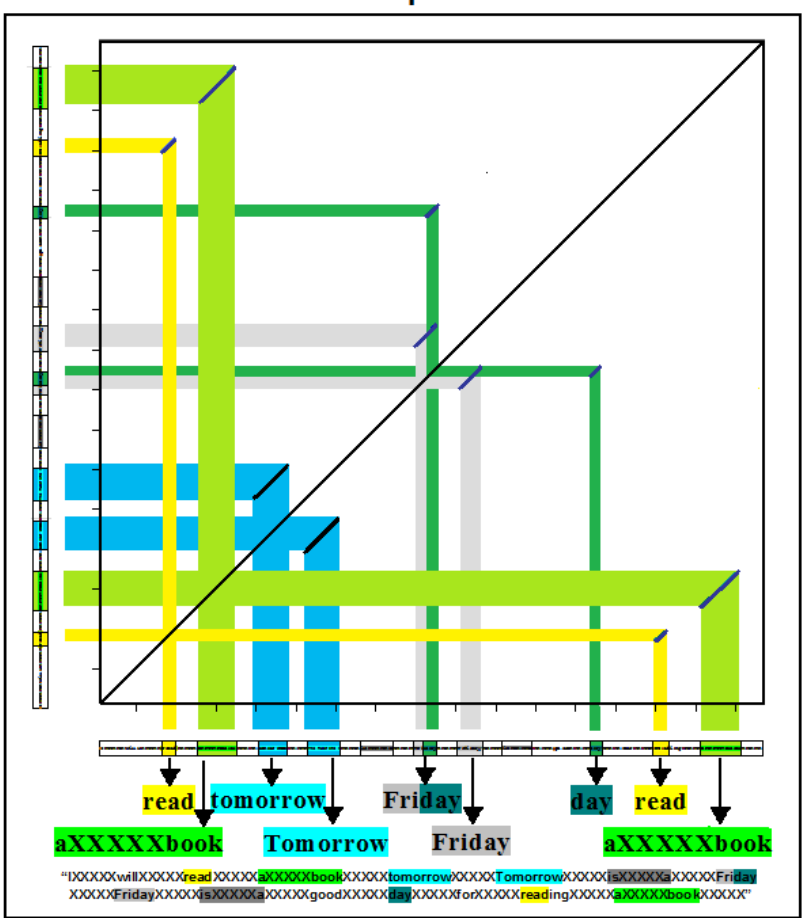
Figure 2. Extraction of information from the text using